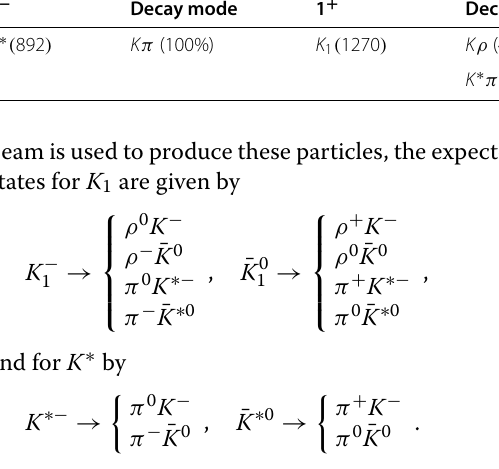
Table 2 Dominant hadronic decay channels of K ∗ and K 1 meson 1 − Decay mode 1 + Decay